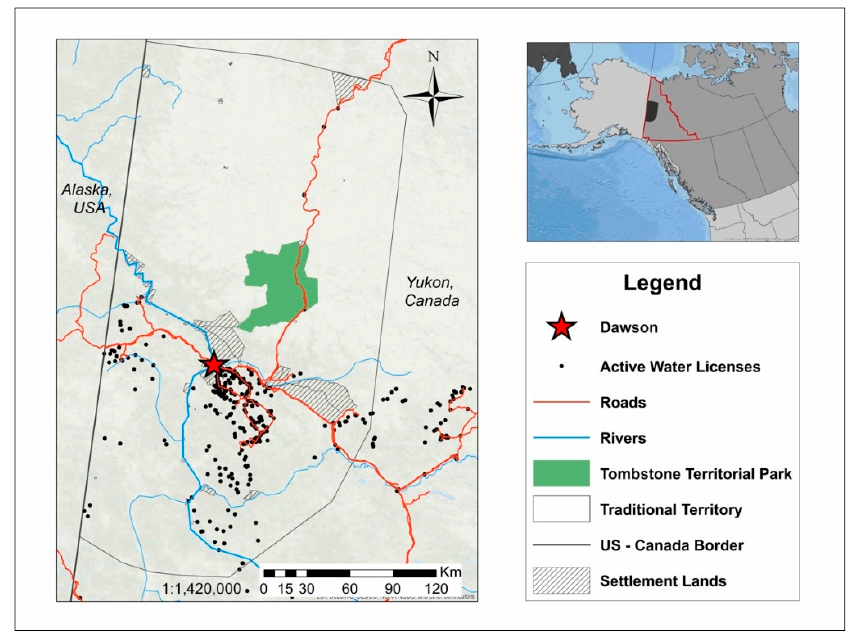
Figure 2. Map of the Tr’ondëk Hwëch’in (TH) Traditional Territory illustrates the spatial distribution of Settlement Lands, active water licenses, and protected areas. Map produced by the lead author.